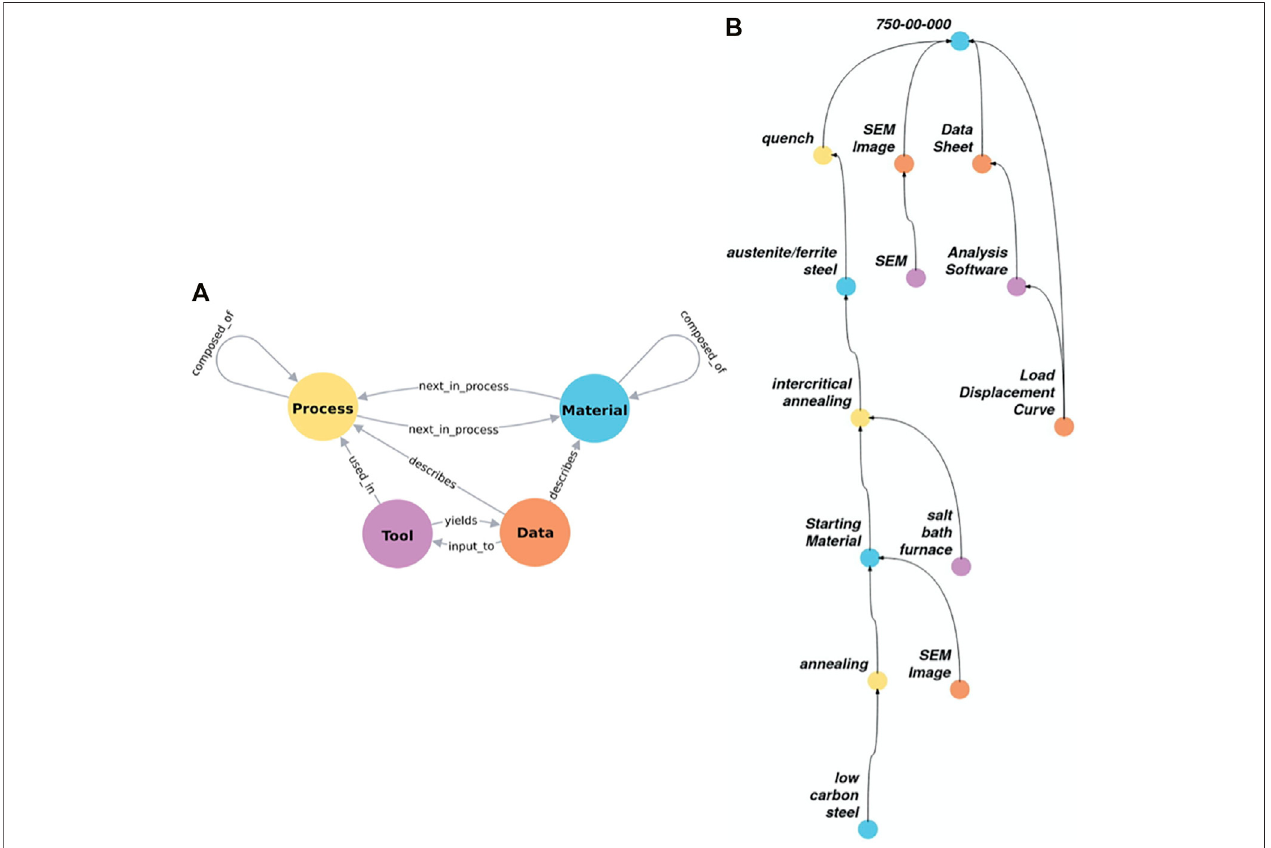
FIGURE7|(A) Theconstitutiveelementsofarecentlyproposedmaterialsontology(VoigtandKalidindi,2021).ThefourmainelementsareMaterial(blue),Process (yellow), Tool (purple), and Data (orange) are shown in different colors along with the allowed connections between them. (B) An example of a knowledge graph constructed using the